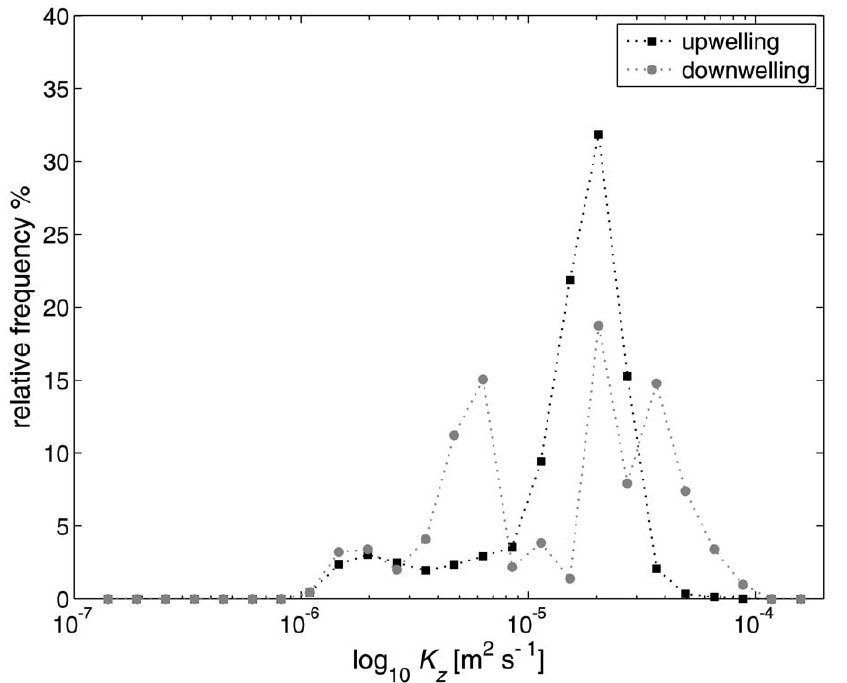
Figure 8. Frequency distributions of turbulent diffusivities at mooring T3. Estimated K z values during upwelling (black) and downwelling (gray) events. The significant asymmetry can be attributed to the unstable BBL stratification observed by temperature inversions during upwelling events at the lakebed.